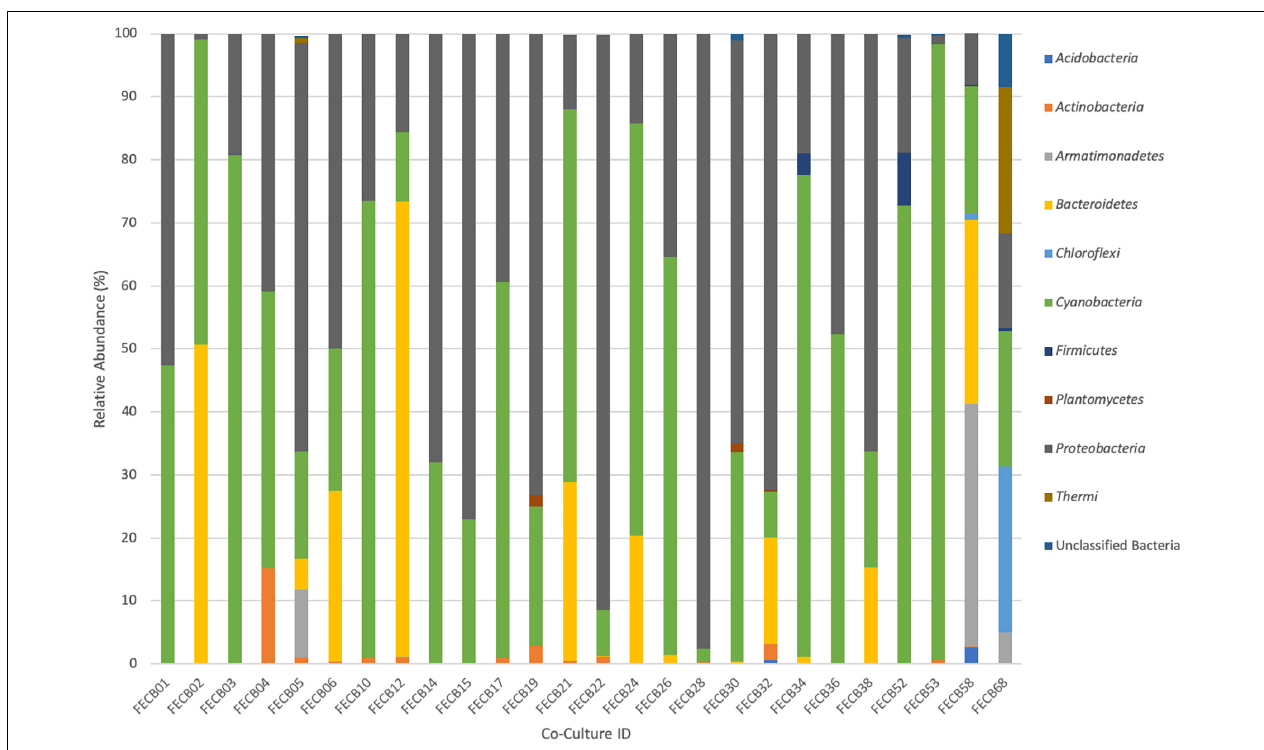
FIGURE 2 | Relative abundance of phyla associated with phototrophic co-cultures. 16S rRNA based community profile. Only phyla recruiting > 0.1% of the reads in at least one of the co-cultures are shown.